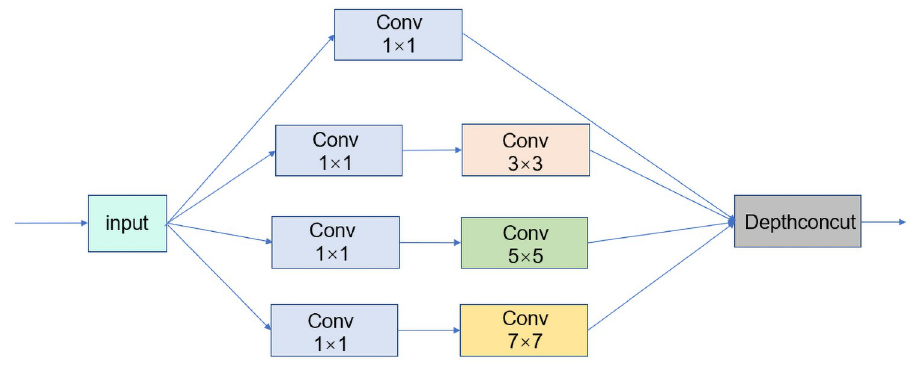
Fig 6. Multi-scale